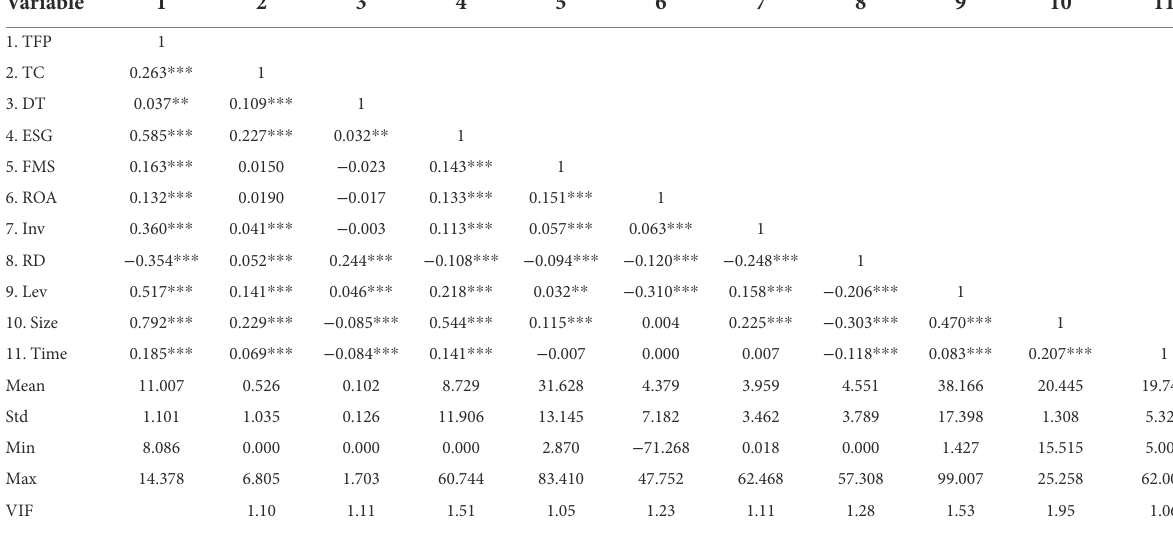
TABLE 2 The results of correlation analysis and multicollinearity